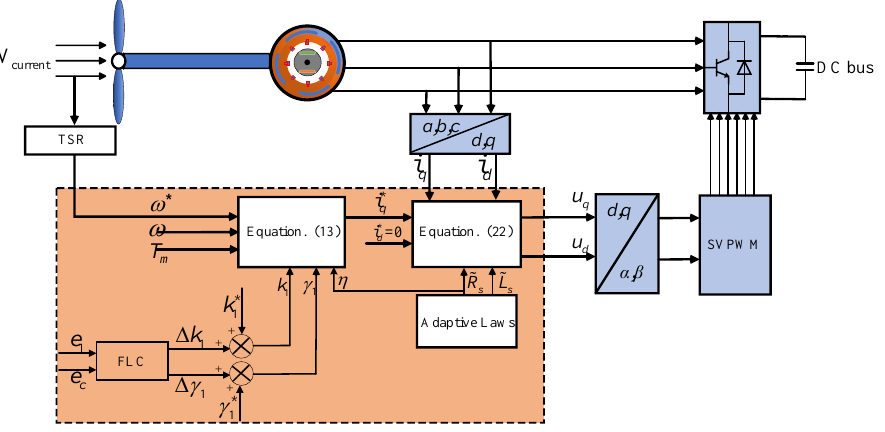
Figure 4. The fuzzy adaptive backstepping control scheme for MCTs.